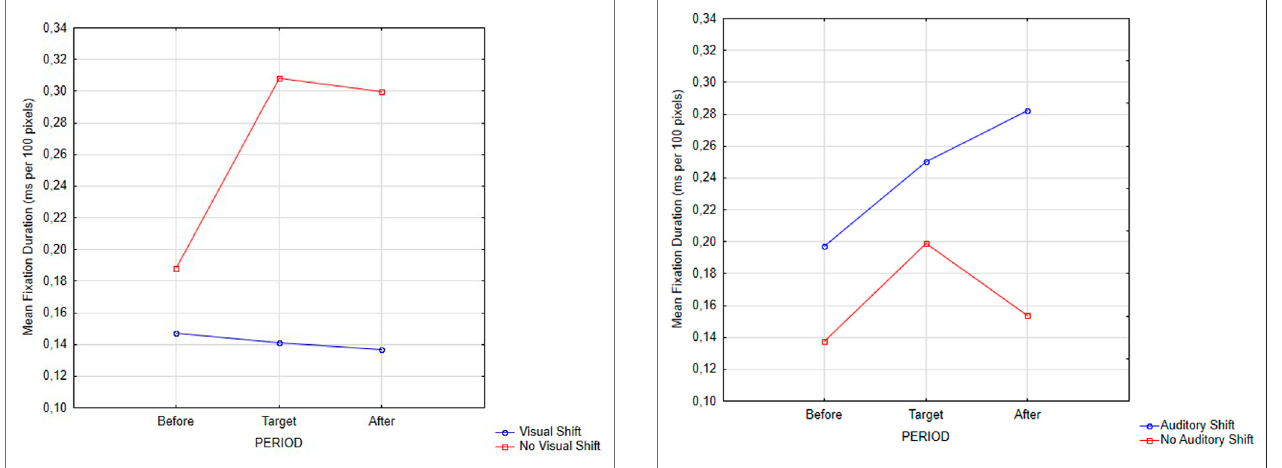
Table 1 ): audio perspective shift (Shift/No Shift) X visual perspective shift (Shift/No Shift) X periods (Before/Target/ After). Analysis was not performed for the visual control condition (grey mask) because there were no stimuli to